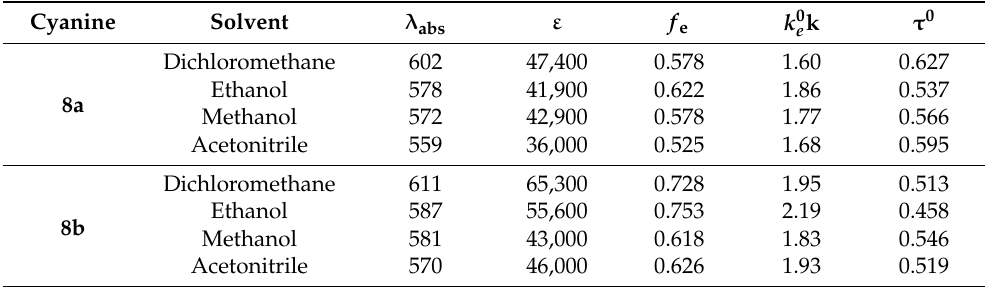
Table 2. Photophysical data of heptamethine cyanine dyes 8a - b in solution, where λ abs is